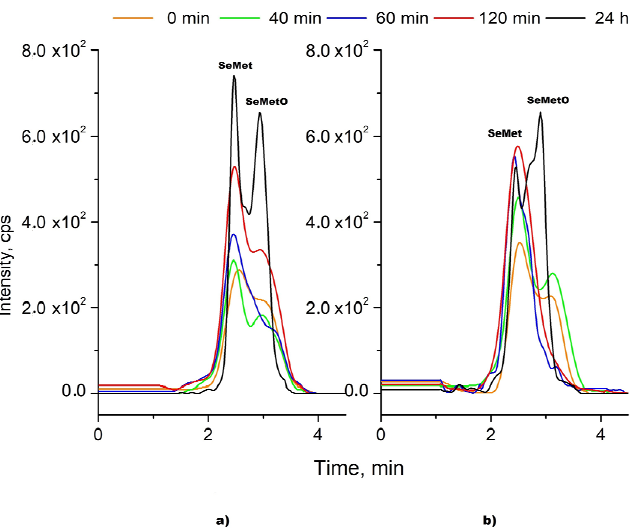
Figure 3. The chromatograms of SeMet and SeMetO mixture standard solutions after the addition of ( a ) β ME and ( b ) DTT in the function of time. Column and eluent as in Figure 2.